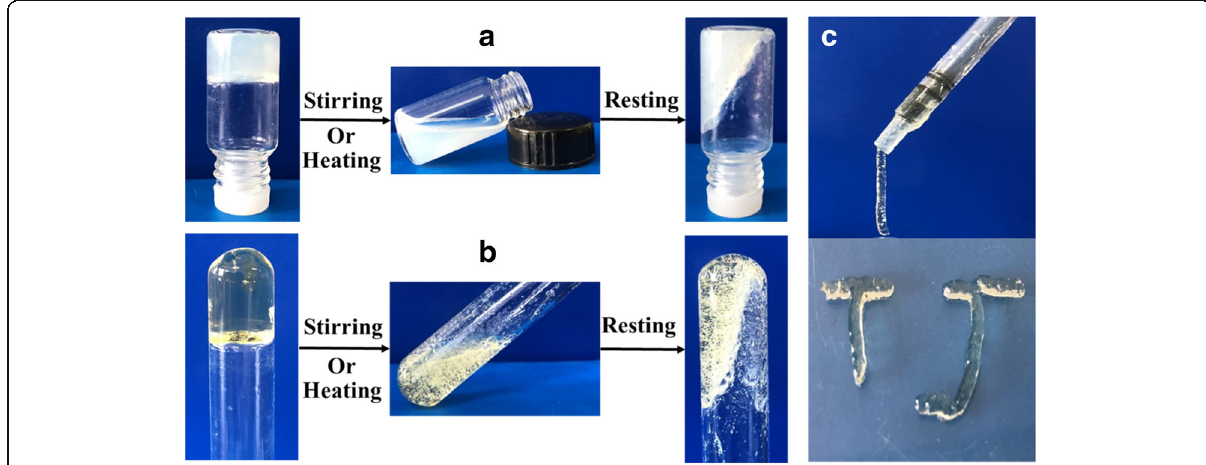
Fig. 1 a Reversible sol-to-gel transitions of G1-A16 room-temperature hydrogel stimulated by shaking or heating at 20 mg mL − 1 . b Reversible sol-to-gel transitions of G1-A16 room-temperature nitrobenzene gel stimulated by shaking or heating at 20 mg mL − 1 . c Extrusion of G1-A16 room-temperature nitrobenzene gel from a